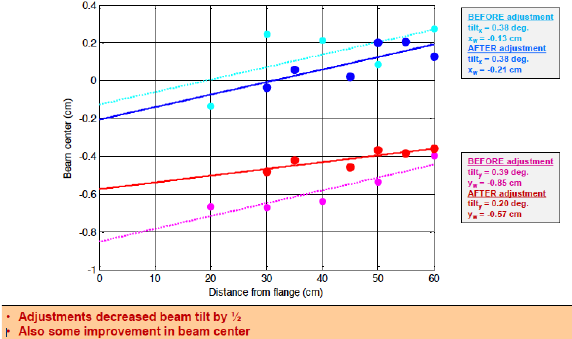
Fig. 5. The tilt and the offset of the transmission line before adjustment and after adjustment.